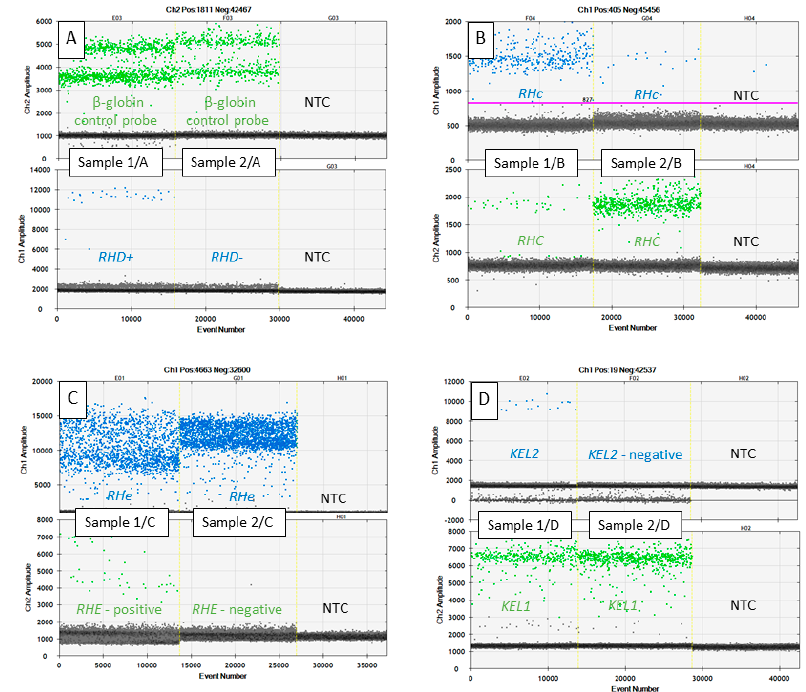
Figure 1. Graphical outputs from one dimensional graph between the fluorescence intensity ( y - axis) and droplet number ( x -axis) of RHD , RHCE , and KEL genotyping from maternal cell-free plasma DNA; ( A ) green channel indicates plasma DNA control β -globin amplification, blue channel indicates RHD exon 7 positive droplets originate from the fetus. Maternal genotype in Sample 1/A is RHD-/RHD- while the fetal genotype is RHD+/RHD- , maternal genotype is RHD-/RHD- and the fetal genotype is also RHD-/RHD- in Sample 2/A; ( B ) blue channel positive droplets indicate variant RHc and green channel indicates RHC variants, maternal genotype in Sample 1/B is RHcc while fetal genotype is RHCc , maternal genotype is RHCC and fetal genotype is RHCc in Sample 2/B. In the case of RHc measurements, the QuantaSoft software was not able to set the cut-off line so it had to be done manually. Therefore, the purple cutoff line is visible; ( C ) green channel positive droplets indicate variant RHE , blue channel positive droplets indicate variant RHe . Plasma DNA sample 1/C contains both the maternal RHee genotype and different RHEe fetal genotype. The same genotypes RHee (maternal and fetal) are shown in the sample 2/C; ( D ) blue channel positive droplets indicate KEL1 variant, green channel positive droplets indicate KEL2 variant. Plasma DNA sample 1/D contains both the maternal KEL2/KEL2 genotype and different KEL1/KEL2 fetal genotype. Sample 2/D illustrates the same KEL2/KEL2 genotypes. NTC: Non-template